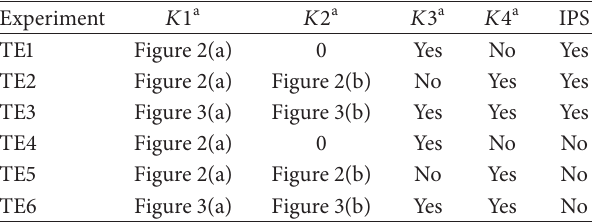
a 𝐾1 and 𝐾2 are the distribution of the IC and the SS, respectively. 𝐾3 represents the case when the IC is inverted and 𝐾4 represents the case when the SS is